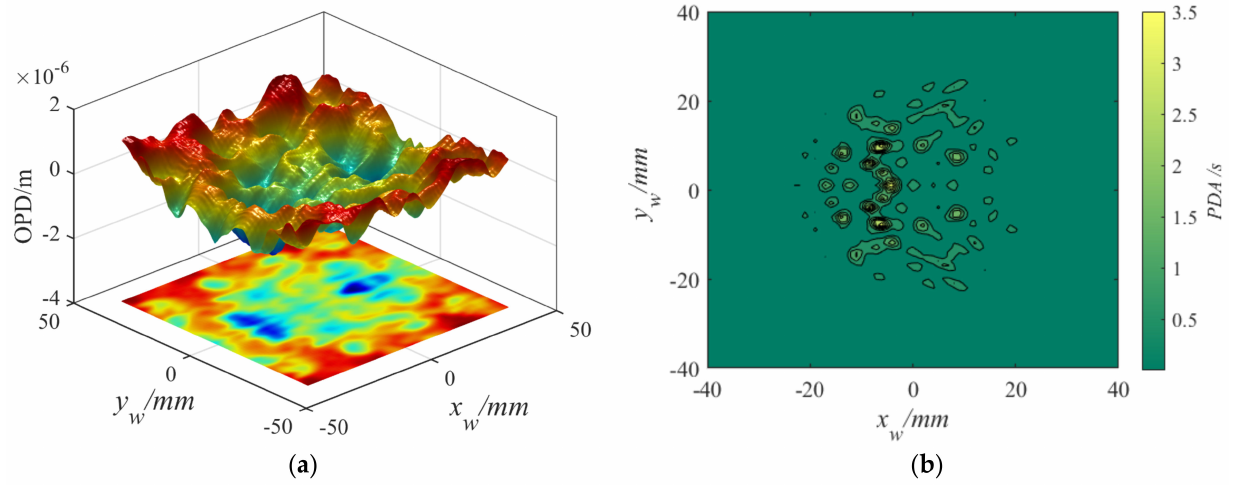
Figure 15. ( a ) OPD distribution according to the traditional method; ( b ) PDA distribution at optical window